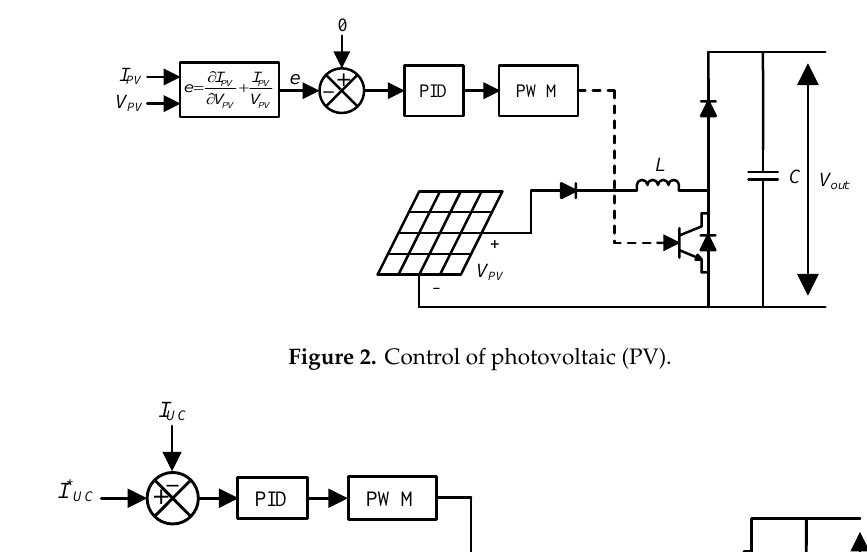
Figure 3. Control of UC.